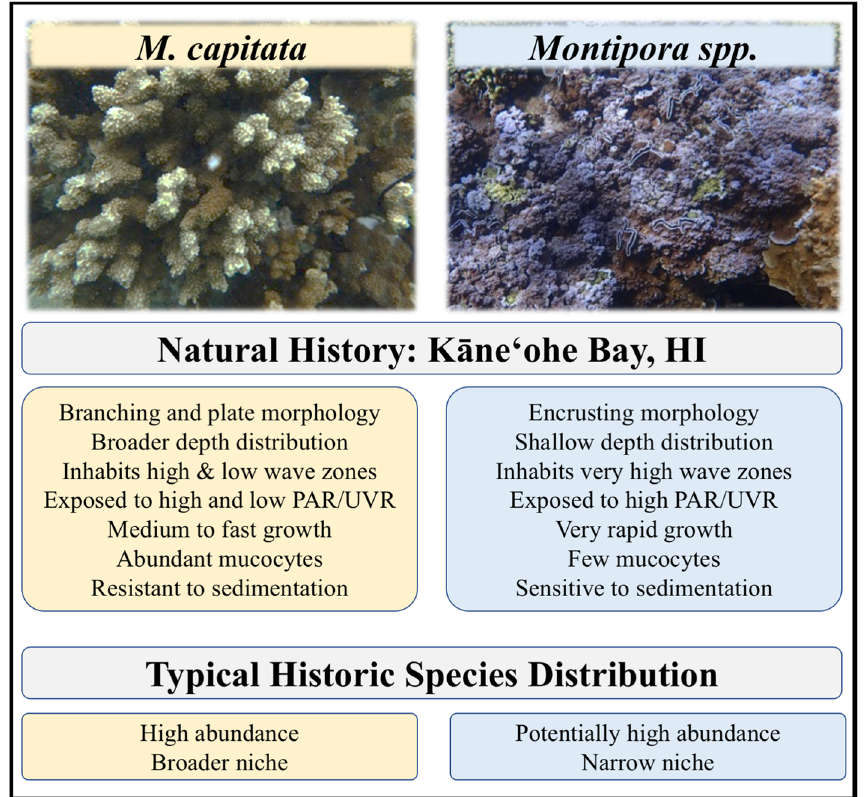
Figure 8. Overview of natural history, traits, and species distribution of M. capitata and Montipora spp . Montipora capitata inhabits a broader range of reef habitat than Montipora spp . which is limited to shallow reefs with high wave and light